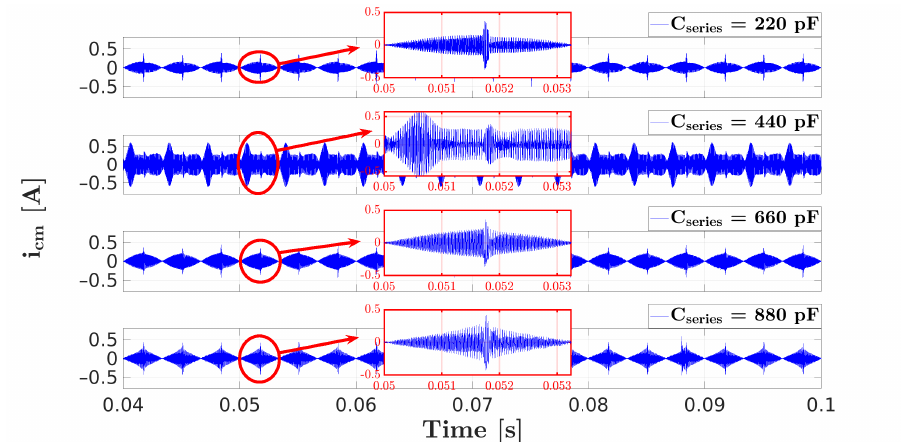
Figure 16. Waveforms of i cm with different values of C series